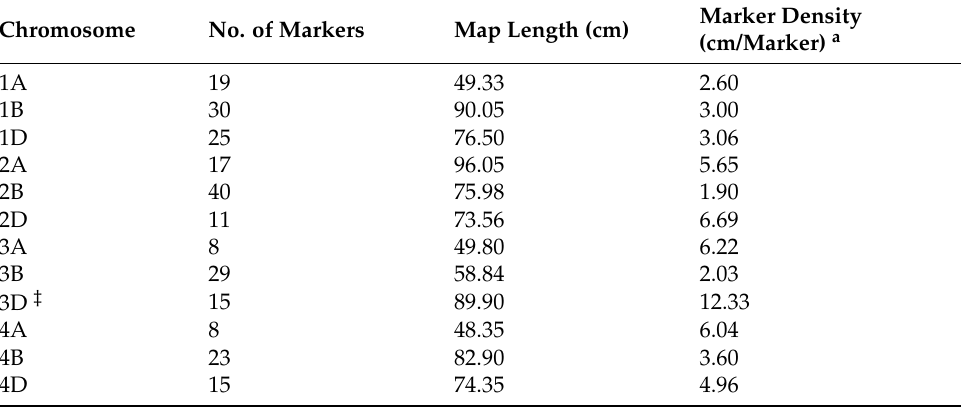
Table 2. Summary of the genetic linkage map of the Tugela-DN × Elands DH population.